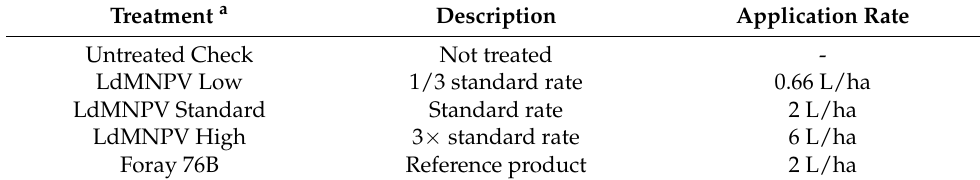
Table 2. Treatments in the dose–response